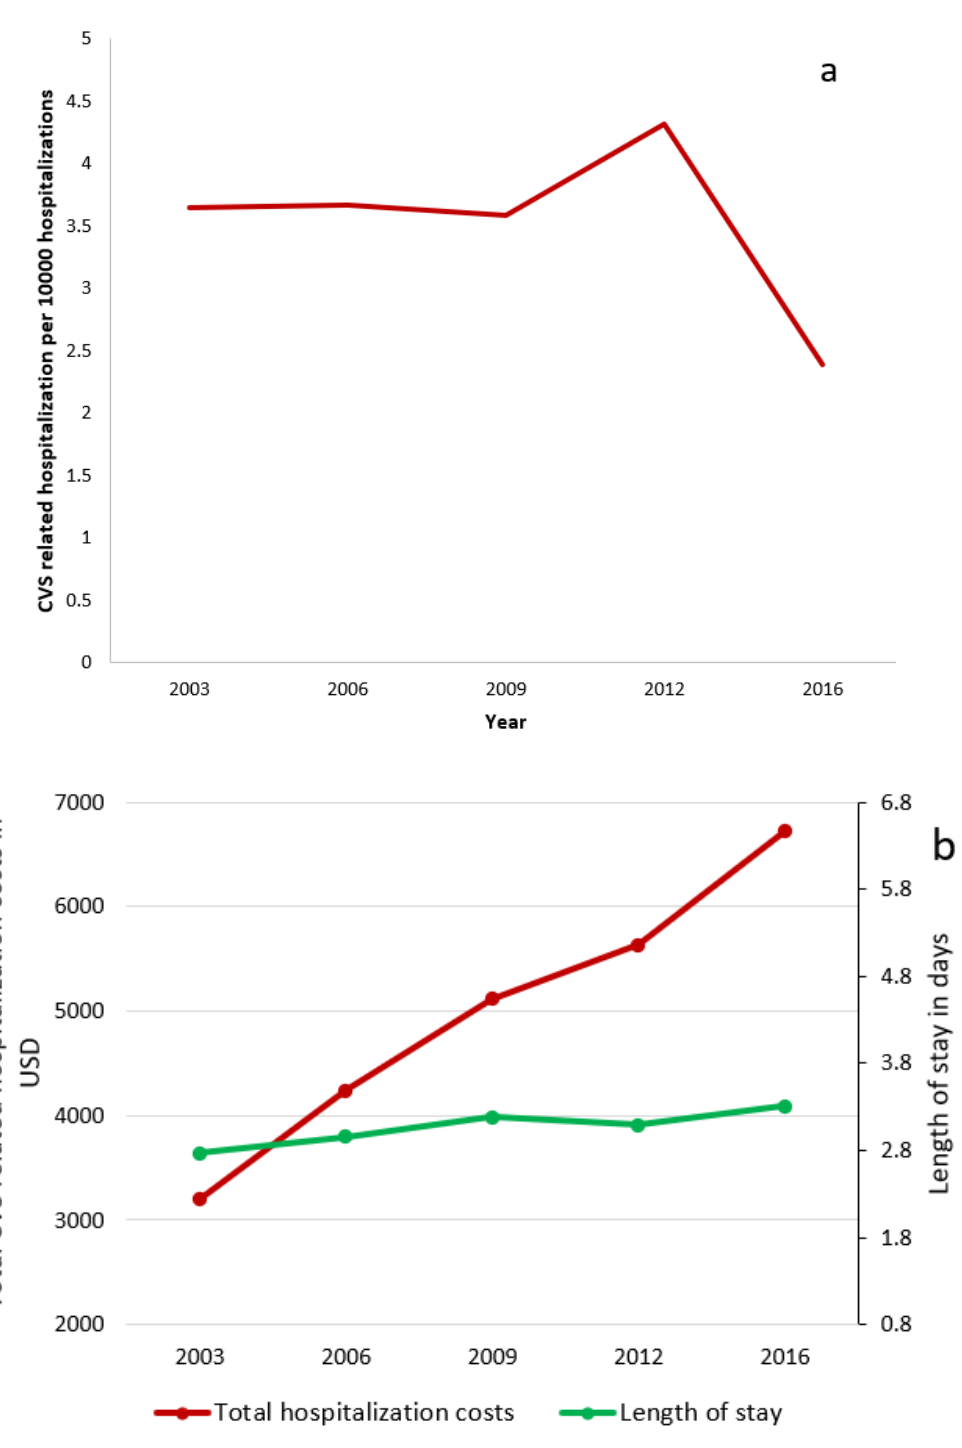
Figure 1. ( a ) Trend of CVS-related hospitalization rate between 2003 and 2016 using KID database; ( b ) Trend of hospitalization costs and length of stay for CVS related hospitalization.